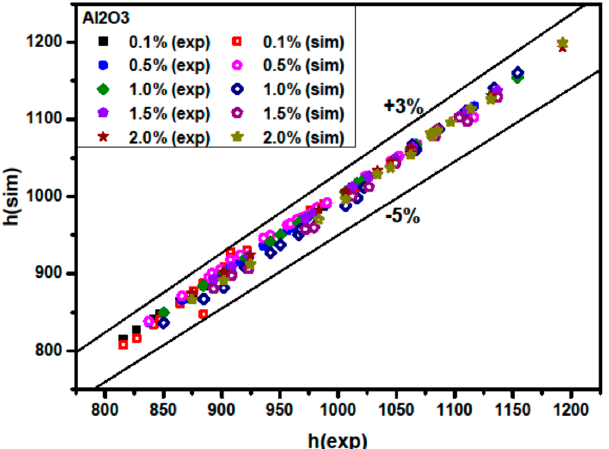
Figure 14. Comparison of the measured and predicted heat transfer coefficient to the water heat transfer coefficient for Al 2 O 3 /water nanofluids.